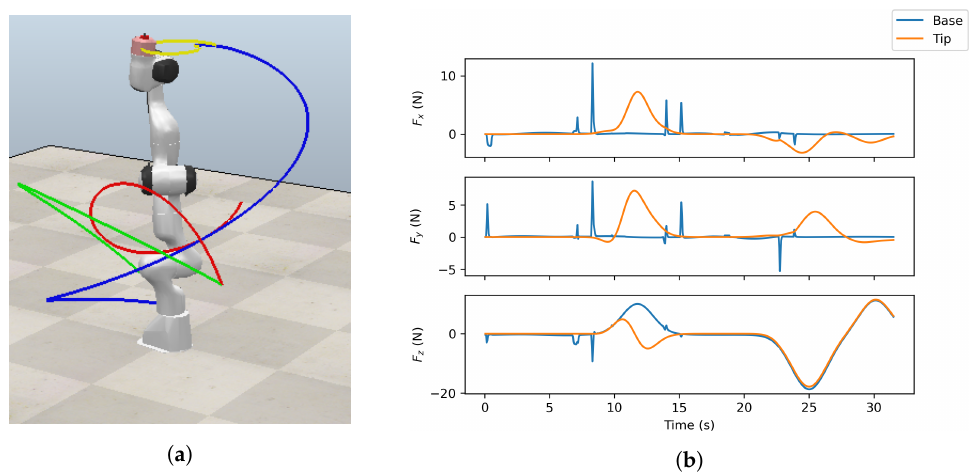
Figure 2. Example of the simulation run: ( a ) CoppeliaSim with four visualized trajectories; ( b ) three corresponding force interactions acting on the base and the end-effector for four visu- alized trajectories.